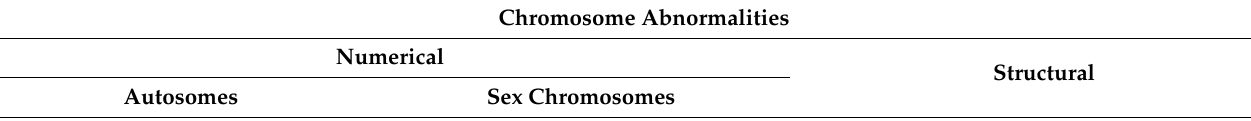
Table 1. Schematic representation of the chromosome abnormalities in domestic